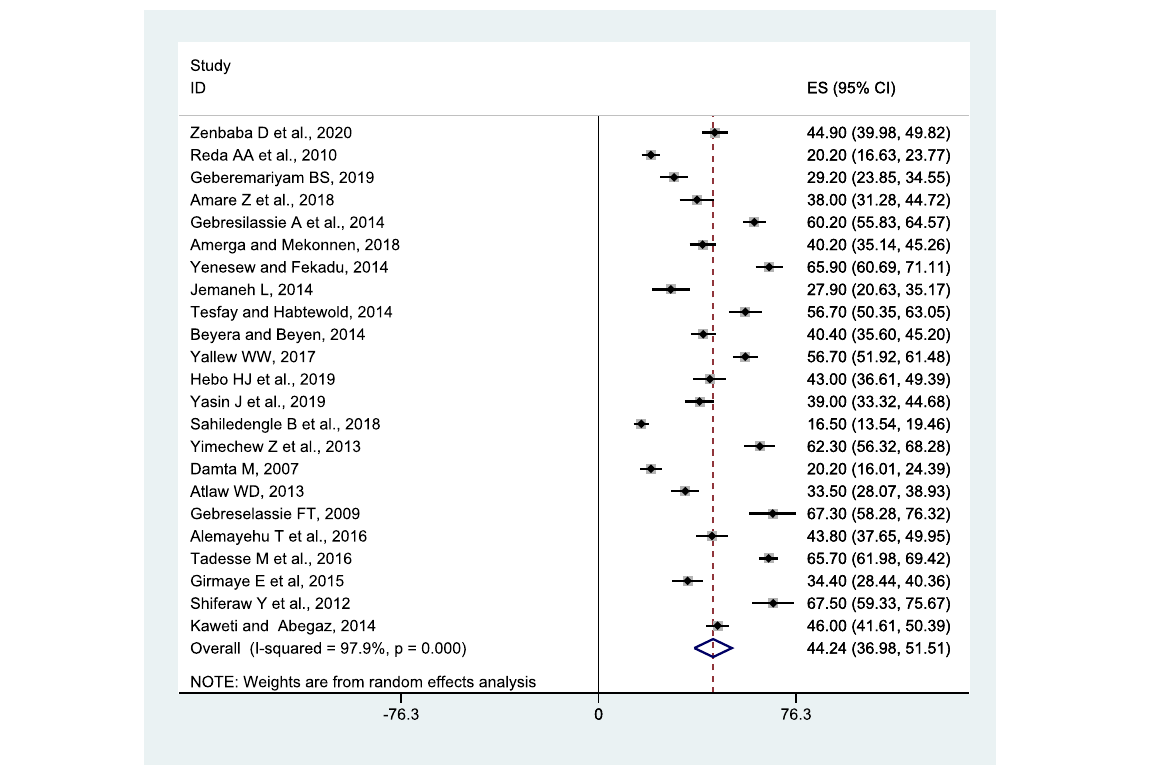
Fig. 2 Meta-analysis, 12-month prevalence of blood and body fluid exposure among healthcare workers in Ethiopia, 2007 –